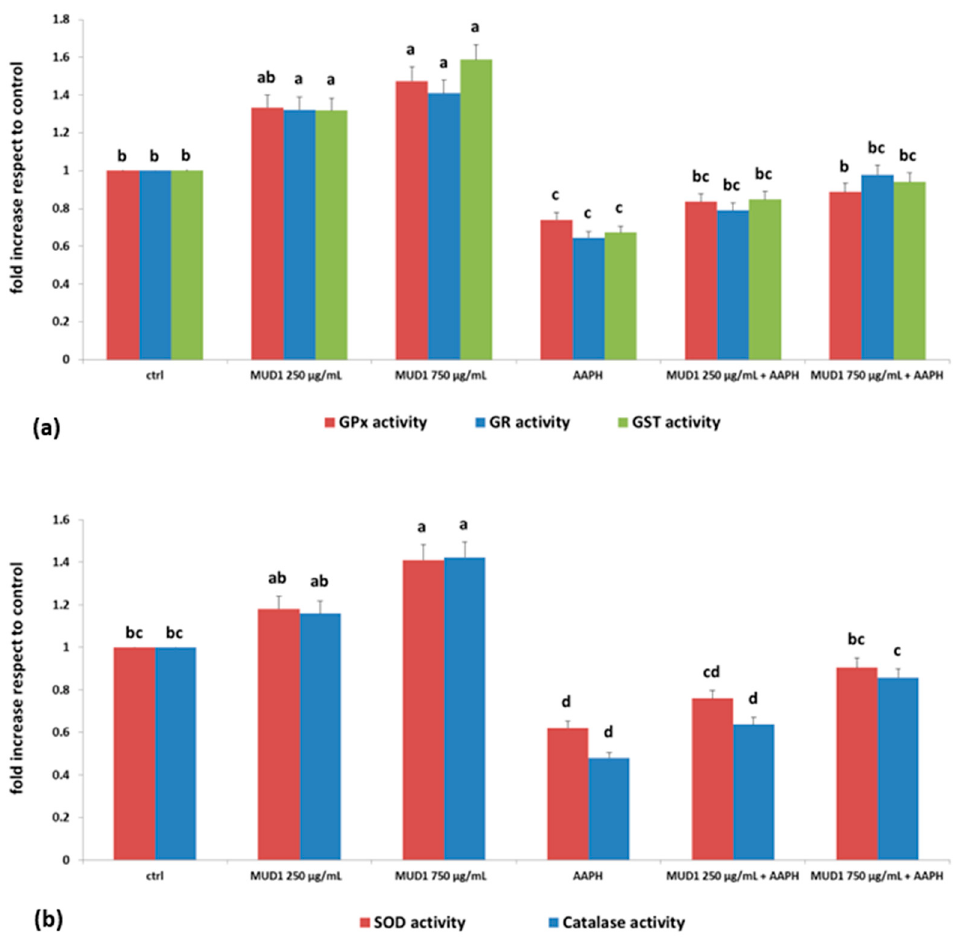
Figure 4. Glutathione peroxidase (GPX), glutathione reductase (GR), glutathione trasferase (GST) ( a ) and superoxide dismutase (SOD) and catalase ( b ) activities cell in HDF cells treated with different concentrations of MUD1 (250–750 µ g/mL) for 24 h or AAPH (10 mM) for 24 h and with different concentrations of MUD1 and then with AAPH. Data are expressed as mean values ± SD. Columns with different superscript letters are significantly different ( p < 0.05).